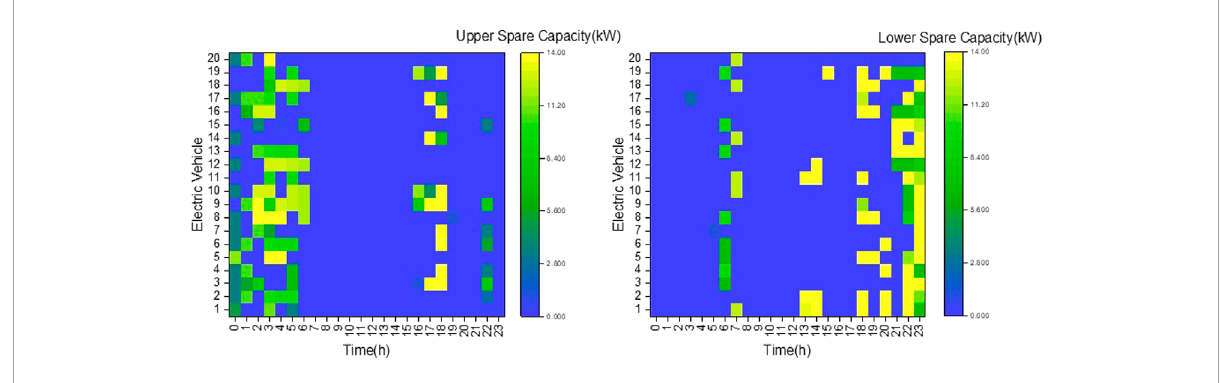
FIGURE 9 Optimization results for electric vehicle reserve capacity when there are 200 electric vehicles.